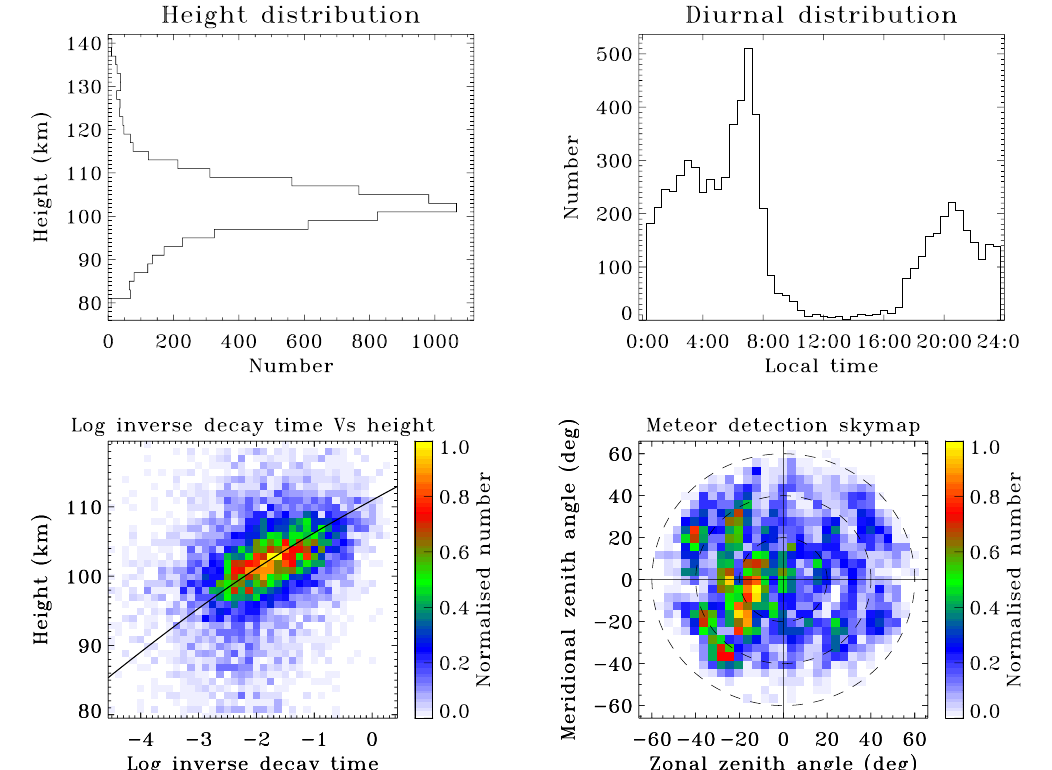
Fig. 8. Meteor distributions for March 2003: height (top left), time (top right), decay times (bottom left) and angle of arrival (bottom right). The dashed lines in the angle of arrival plot indicate zenith angles of 20 ◦ , 40 ◦ , and 60 ◦ . The solid line in the decay time plot indicates the theoretical value estimated using CIRA temperature and pressure.